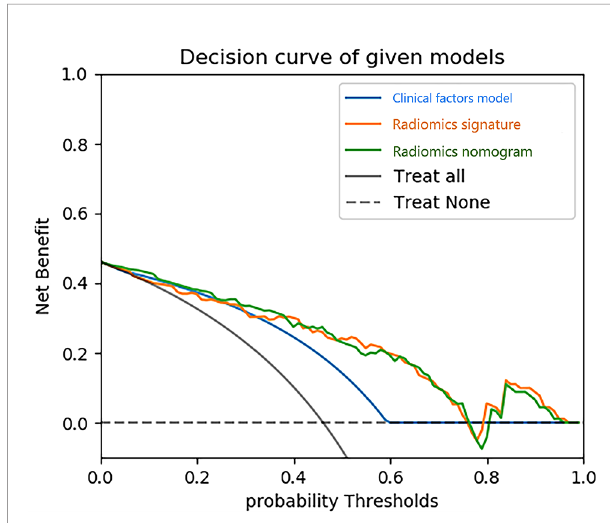
FIGURE 9 | Decision curve analysis (DCA) for three models. The y-axis indicates the net bene fi t; x-axis indicates probability thresholds. The blue line, yellow line and green line represent net bene fi t of the clinical factors model, the radiomics signature and the radiomics nomogram, respectively. Both the radiomics nomogram and the radiomics signature showed a higher overall net bene fi t in differentiating type 1 from type 2 than the clinical factors